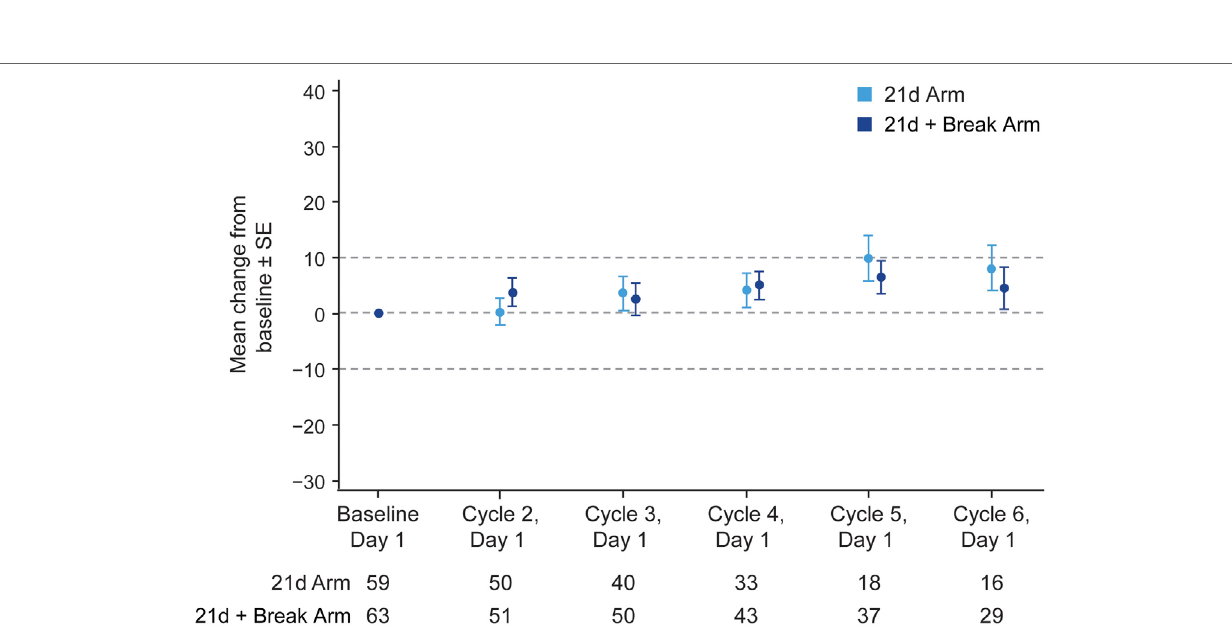
FigUre 5 | Change in LCSS pulmonary symptom score from baseline by treatment arm. Abbreviation: LCSS, Lung Cancer Symptom Scale. *Not all patients completed assessments at all the time points.